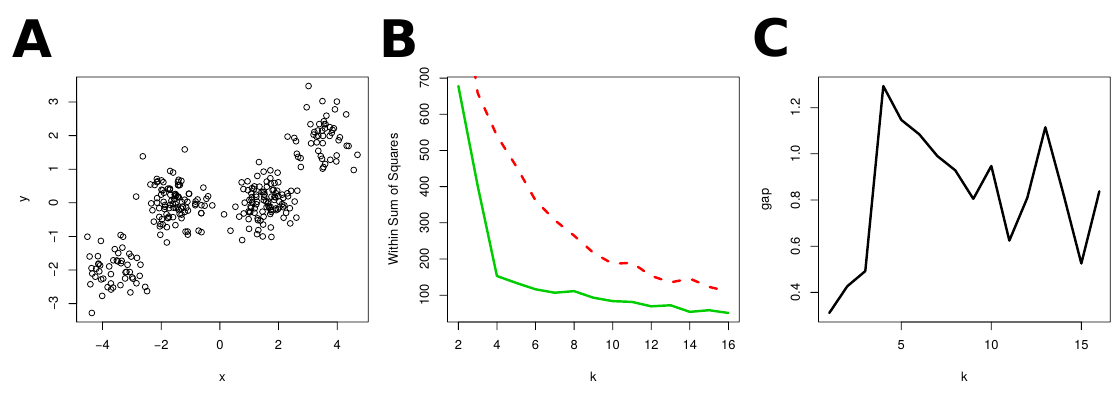
Figure 4: (A) a toy dataset consisting of 4 spherical clusters with 300 objects in total. (B) depicts the within sum of squares, i.e., the distance of the objects to their cluster centers for varying k . The green solid line depicts the value for the dataset, the red dashed line depicts the value for a background model without cluster structure for the gap statistic. The green line shows a clear elbow at the actual cluster size four. (C) depicts the gap statistic with the peak at 4